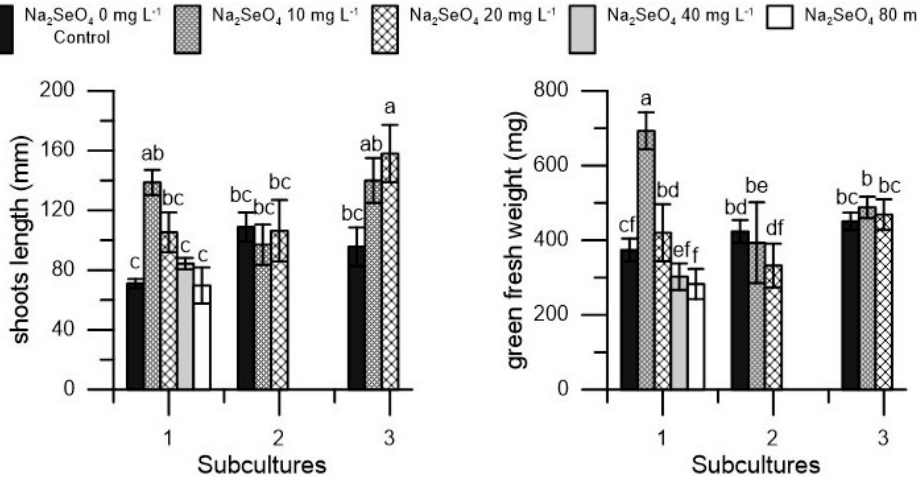
Figure 2. Shoot length (mm) and green fresh weight (mg) in ‘Moraiolo’ cv. in three different subcultures (1, 2, and 3) at five dosage of Na 2 SeO 4 (0, 10, 20, 40 and 80 mg L − 1 ) during the first subculture and at three dosages of Na 2 SeO 4 (0, 10, and 20 mg L − 1 ) during the second and third subculture. Each value represents the average of three replicates ± SEM. Mean values followed by different letters were significantly different ( p < 0.05).